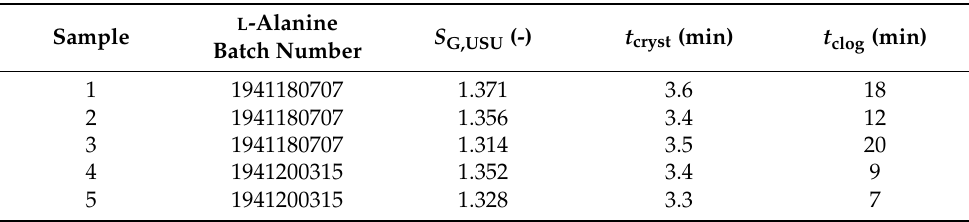
Table 4. Combined nucleation and crystal growth: supersaturation, time until visible crystals appear,